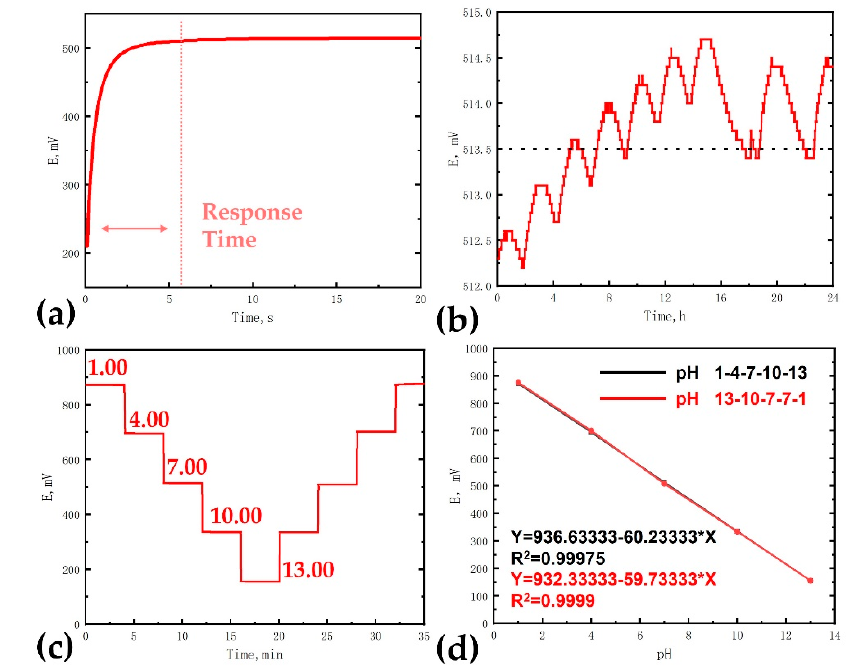
Figure 8. The measurement of pH sensing of iridium oxide pH microelectrodes: ( a ) response time, ( b ) potential stability test, ( c ) potential response to pH changes for acid-to-base and base-to-acid, ( d ) potential-pH dependence for acid-to-base and base-to-acid.